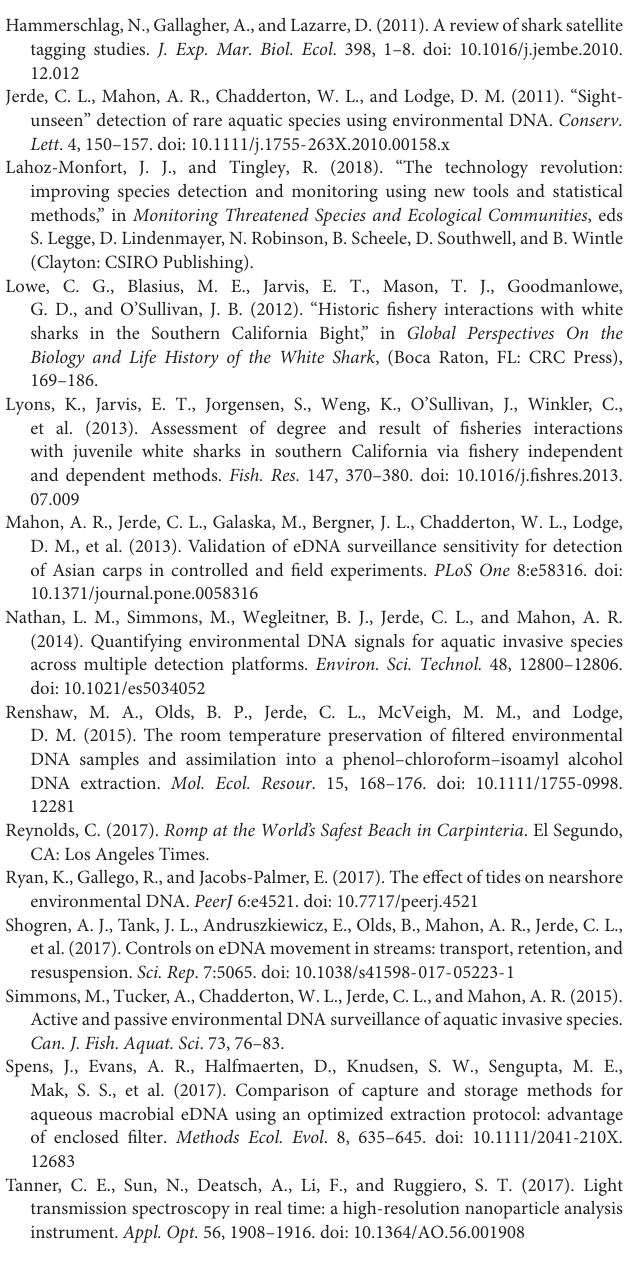
FIGURE S1 | Alignments by species. FIGURE S2 | Thresholds for positive detection. No negative controls or negative samples had droplets over 4000 (an arbitrary fluorescence amplitude scale set by the software). Positives were defined as droplets over